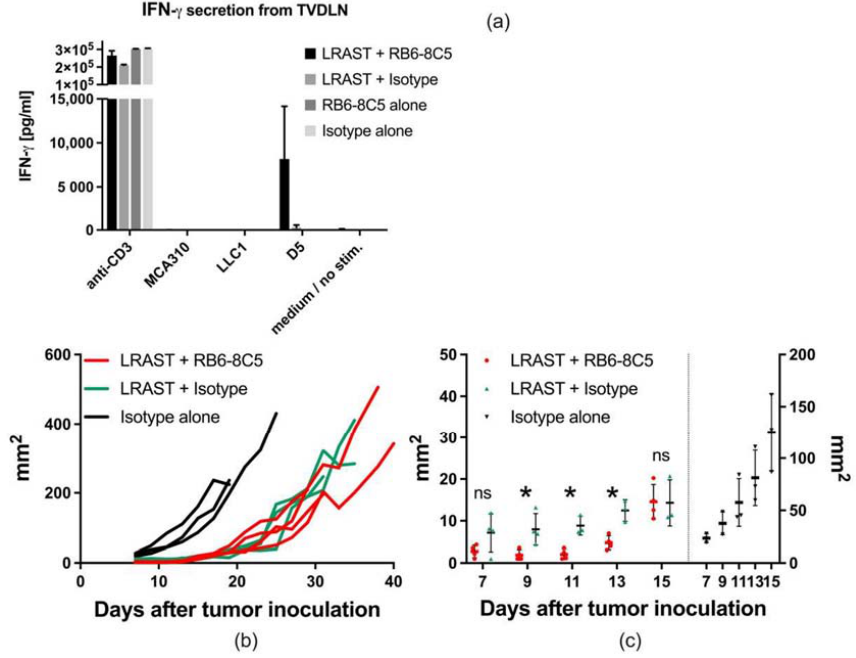
Figure 4. Cytokine response and effect on tumor growth after combining LRAST with anti-Gr-1 antibody treatment . ( a ) C57BL/6-mice were subcutaneously injected with 20 × 10 4 D5-cells (5 × 10 4 at each flank nearby the proximal extremities) and treated according to LRAST w/o MDSC depletion with anti-Gr-1 mAb (clone RB6-8C5) ( n = 2–4 per group). Mice were euthanized on day 9 after lymphodepletion, and inguinal as well as axillary lymphatic nodules were harvested. T cells from TVDLN were polyclonally stimulated with anti-CD3 mAb and expanded with IL-2. To assess tumor- specific IFN- γ release, cells were incubated with autologous tumor cells of the D5-lineage or control tumor cell-lines (MCA310 and LLC1). Wells coated with anti-CD3 mAb served as positive controls, and wells with native RPMI cell culture medium represented negative controls. Bars represent means with SEM. ( b ) Subcutaneous tumor growth of mice treated with LRAST alone (green), LRAST combined with RB6-8C5 (red), or isotype control (black) ( n = 4 for both LRAST groups, n = 3 for isotype control group). Maximum and minimum diameter of the tumors were determined using caliper and the multiplication product (in mm 2 ) depicted against time (in days). Each line represents one mouse of the respective treatment group. ( c ) Comparison of mice treated with LRAST alone versus mice treated with a combination of LRAST and RB6-8C5, focusing on the initial treatment phase (days 7–15). Dots represent values of single mice. Error bars indicate means with SD. Student’s t test was performed. Symbols indicate: * p < 0.05; ns p >